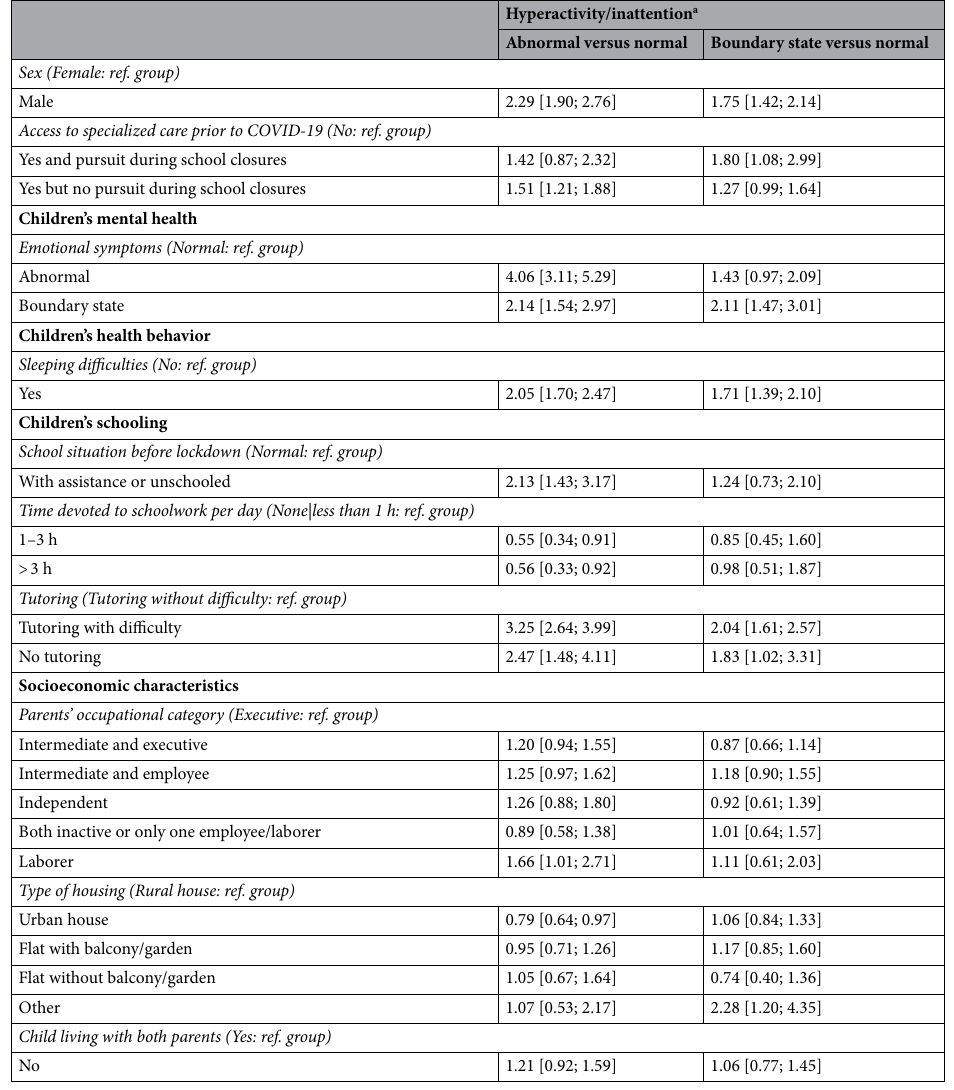
Table 5. Associations between most predictive factors from elastic net selection and hyperactivity/inattention symptoms: multivariate multinomial logistic regressions (n = 5097). a Adjusted on sex, prematurity, access to specialized care prior to COVID-19 and its continuation during school closures, emotional symptoms, sleeping difficulties, school situation before lockdown, time devoted to schoolwork, tutoring, parents’ occupational category, type of housing, and child living with both